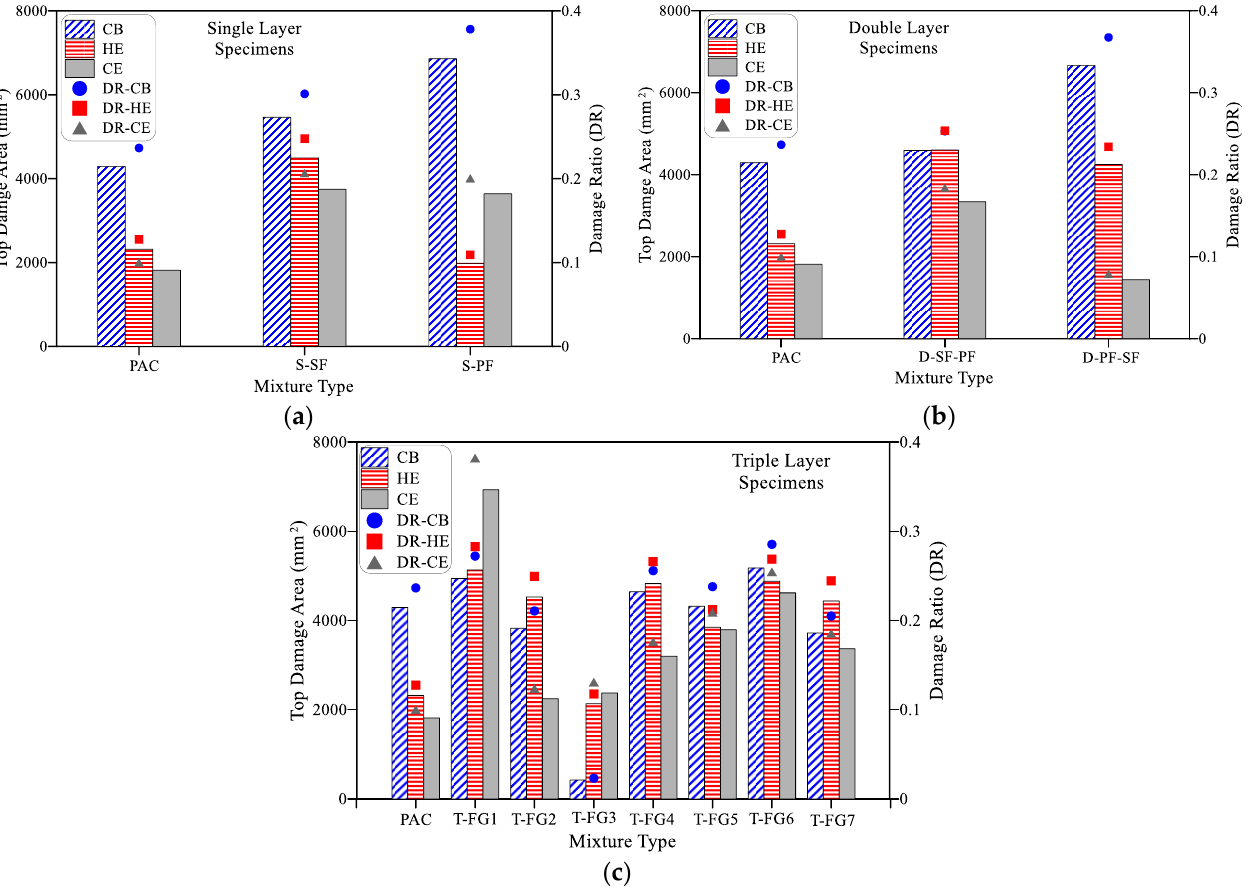
Figure 13. Top damaged area of the three groups of specimens FPAFC ( a ) Single layer, ( b ) Double layer and ( c ) Triple layer.